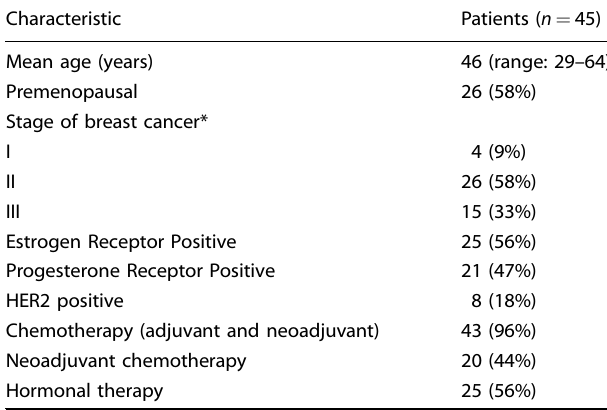
Table 1. Baseline patient characteristics.